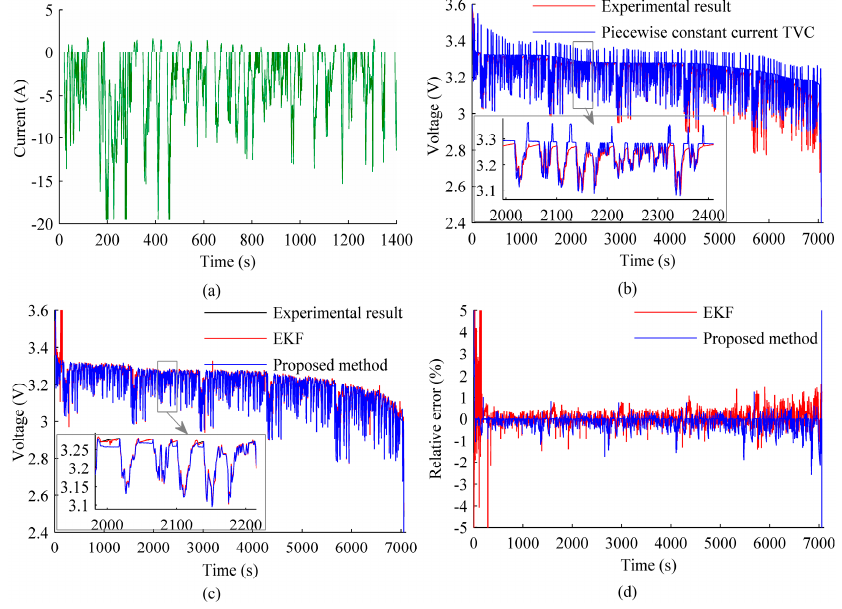
Figure 14. ( a ) Current curve (a FUDS cycle); ( b ) TVCs; ( c ) Modeling results and ( d ) Modeling error FUDS.